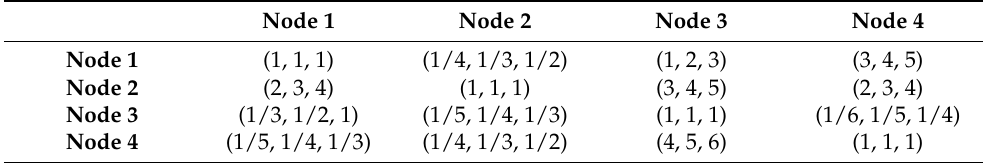
Table A6. Pairwise comparison matrix for No. neighbors criterion as TFN.